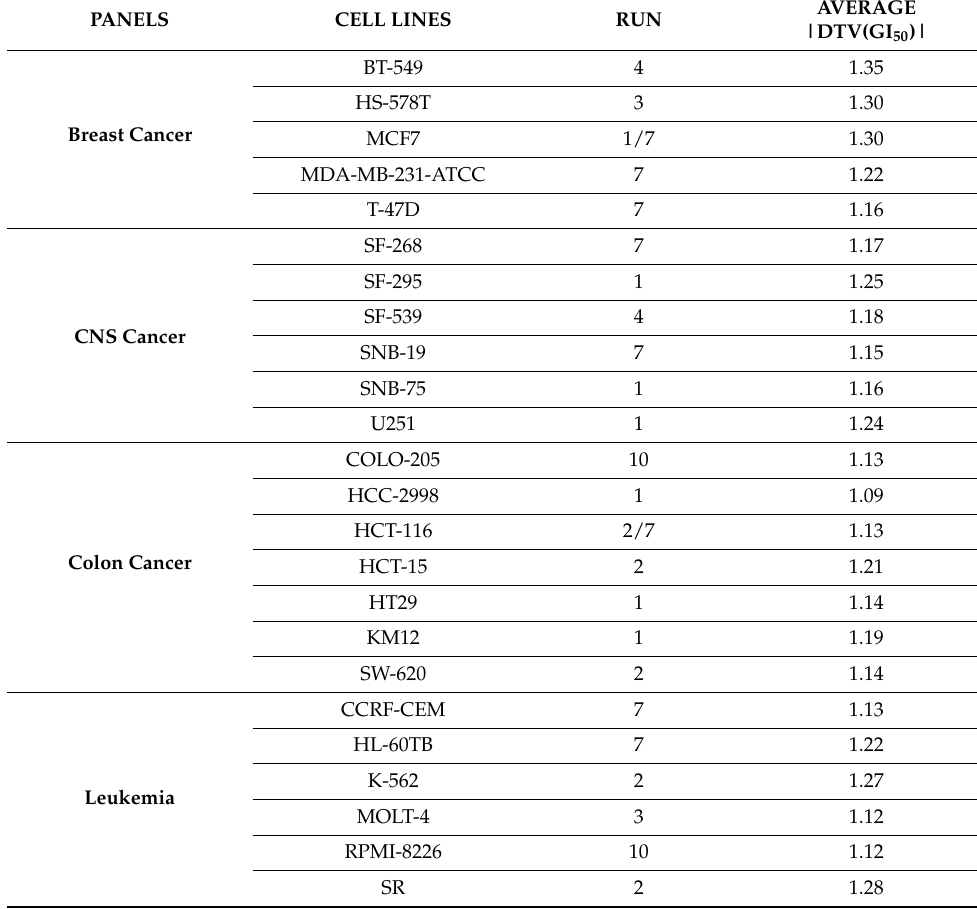
Table 2. Tuning of DRUDIT parameters for each cancer cell line.